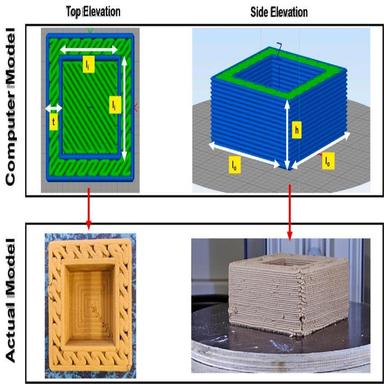
Schematic illustration of CAD model designed for four-walled structures and the resultant 3DP structure.